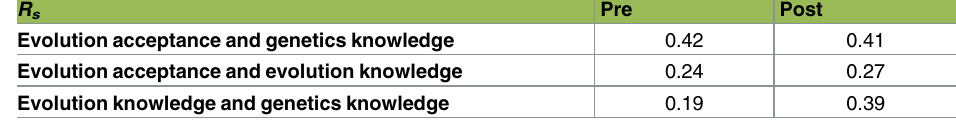
Table 1. Spearman correlations between evolution acceptance,genetics knowledge, and evolution knowledge. All correlationsare highly significant( p < .001). These pretests were done with data where stu- dents had answeredall 3 preteachingquestionnaires ( n = 1,610). For the post-test scores, we again required all 3 assessments to be completed( n = 1,397). Raw data can be found in S1 and S2 Data. R s Pre Post Evolution acceptance and genetics knowledge 0.42